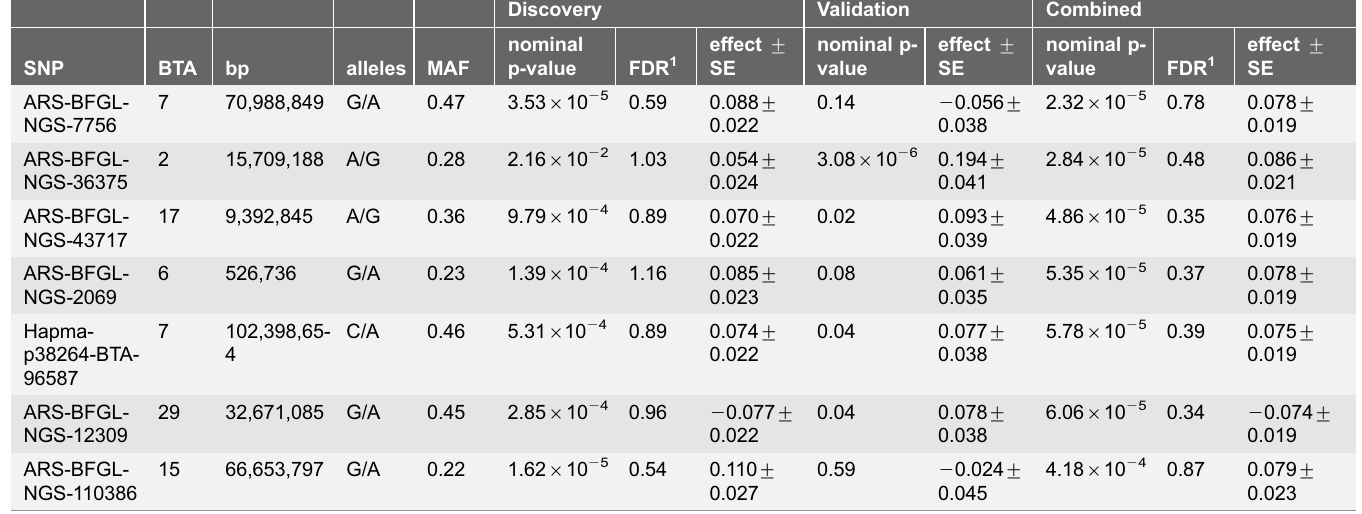
Table 1. SNP associations from GRAMMAR-GC analysis.